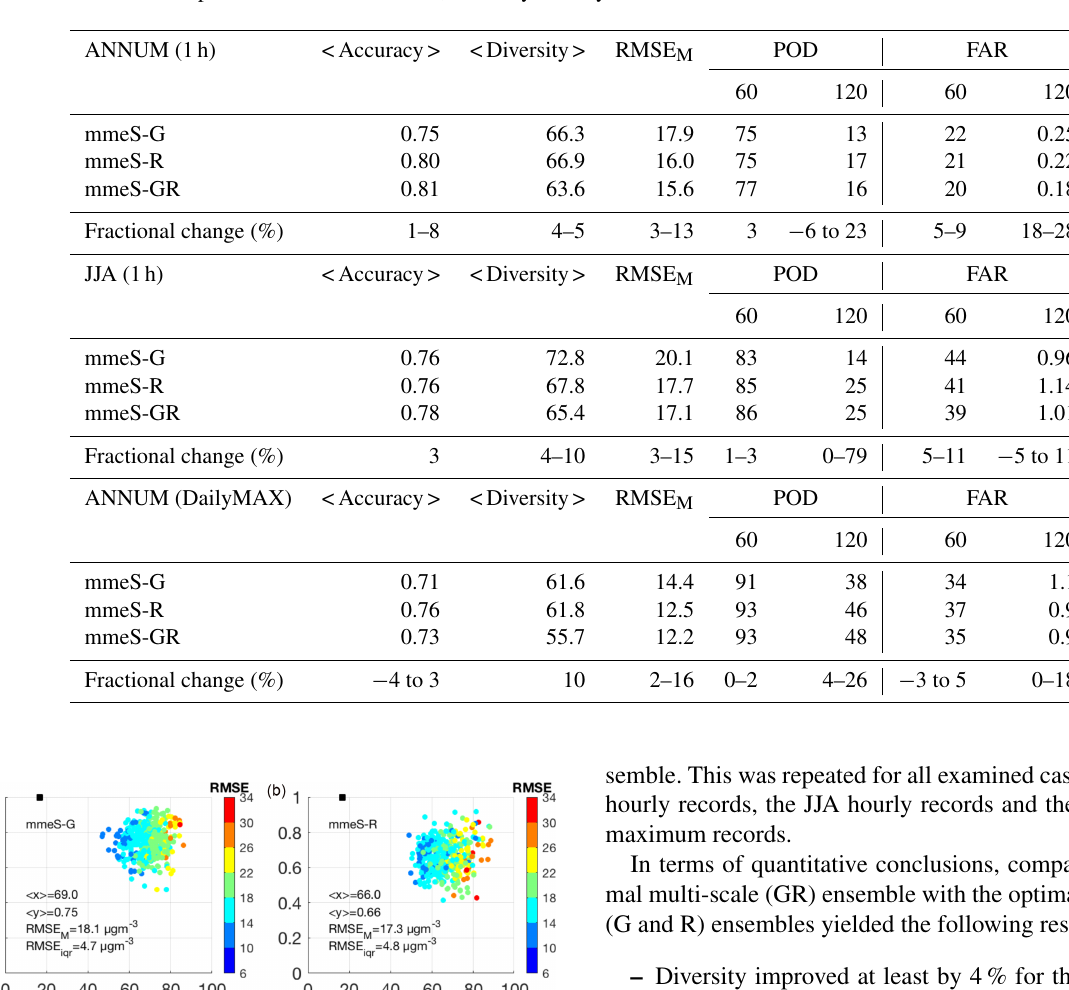
Table 3. The fractional change achieved in accuracy, diversity, RMSE, POD and FAR when moving from single-scale to multi-scale ensem- bles. Results consider the optimal ensembles of rank 6, at hourly or daily maximum resolution.